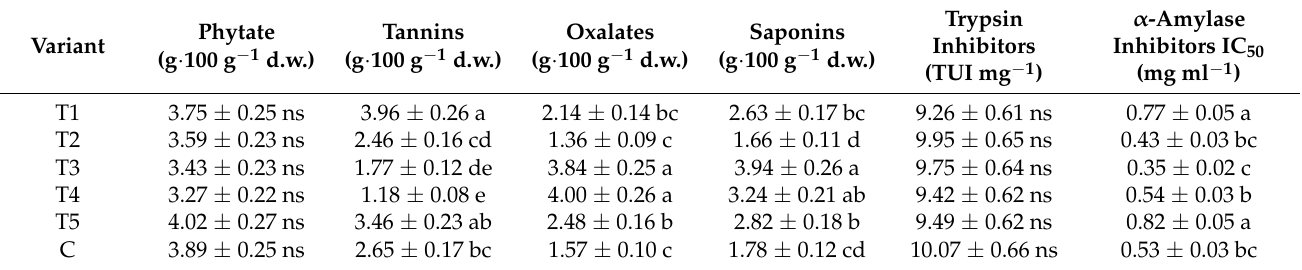
Table 7. The antinutritional composition of tomato fruits under different electric current treatments.